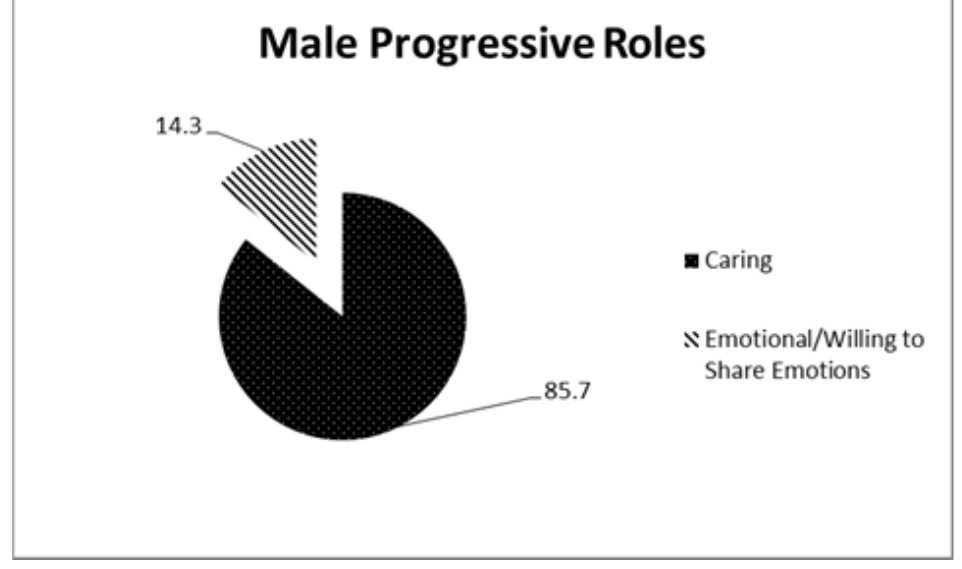
Male progressive roles. Though male characters infrequently exhibited any progressive trait, those that did engage in progressive roles most often did so through a willingness to share